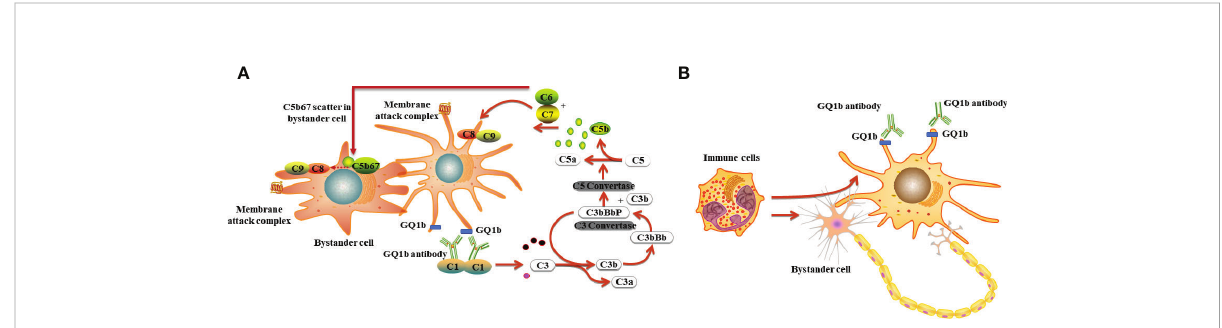
FIGURE 3 The possible mechanisms underlying anti-GQ1b antibody syndrome following M. pneumoniae infection. (A) Complement dependent cytotoxicity: antibody binding to antigen produced antigen – antibody complexes, followed by activated, soluble complement protein deposition forming a membrane-attack complex on nearby non-GQ1b expressing cells, resulting in bystander injury and causing damage to cells not expressing GQ1b; (B) Antibody-dependent cell-mediated cytotoxicity: antigen – antibody complex formation recruiting T cells or other immune cells to engulf damaged cells including nearby non-GQ1b expressing cells.